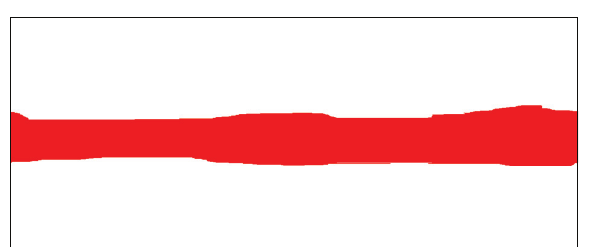
Figure 15: Candidate pipe